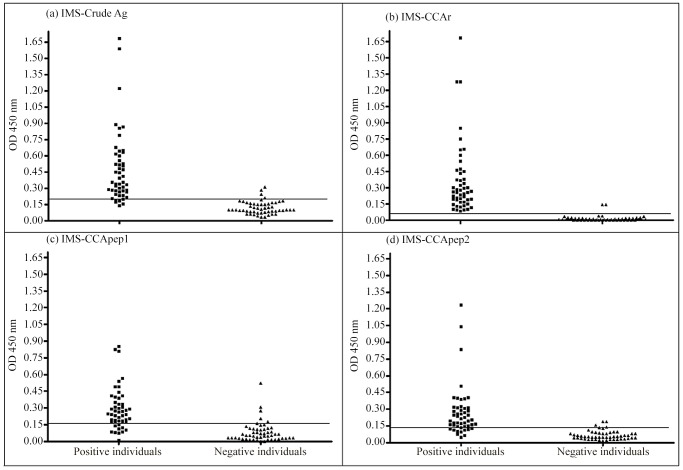
Individual analysis of 102 serum samples by the IMS protocols.Each OD value is representative for the mean of four absorbance values. Cut-off values are represented by bars. In (a) IMS-crude Ag (cut-off = 0.20); (b) IMS-CCAr (cut-off = 0.06); (c) IMS-CCApep1 (cut-off = 0.16); and (d) IMS-CCApep2 (cut-off = 0.13). Artwork created by Prism 5.0 software.